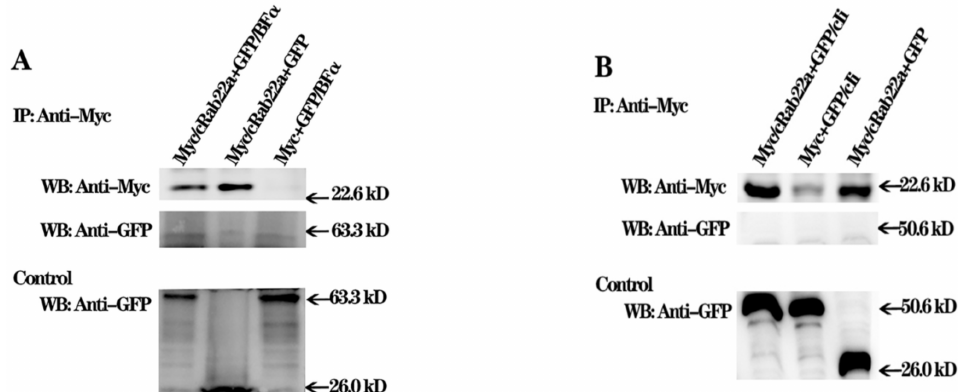
Figure 6. Western blotting for the detection of linkage or binding of Myc/cRab22a with GFP/BF α and GFP/cIi. ( A ) ; The detection of linkage or binding of Myc/cRab22a with GFP/BF α . ( B ) ; The detection of link-age or binding of Myc/cRab22a with